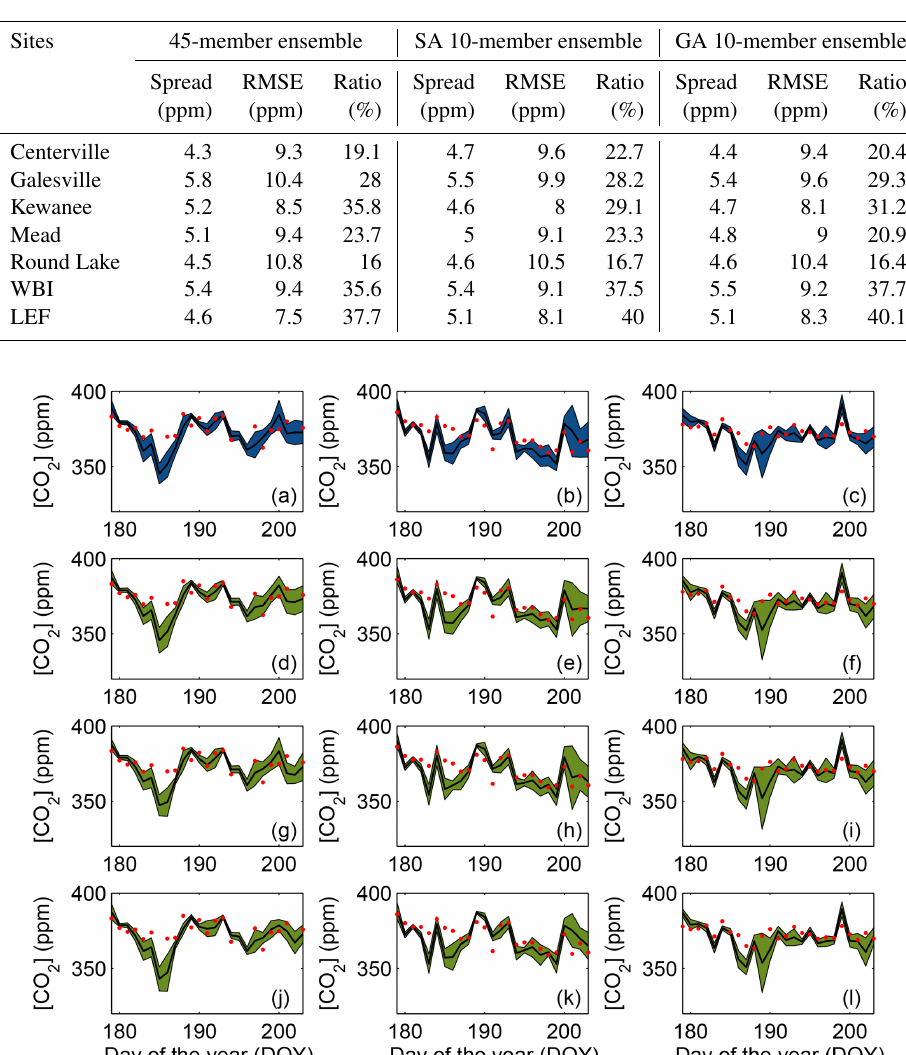
Figure 13. Ensemble mean and spread (i.e., RMSD) of the DDA at approximately 100m CO 2 concentrations at Mead (first column; a, d, g, j ), WBI (middle column; b, e, h, k ) and WLEF (last column; c, f, i, l ) towers using SA-calibrated ensembles. Rows from top to bottom are 45-, 10-, 8- and 5-member ensembles. The blue area is the spread of the 45-member ensemble, the green area is the spread is the spread